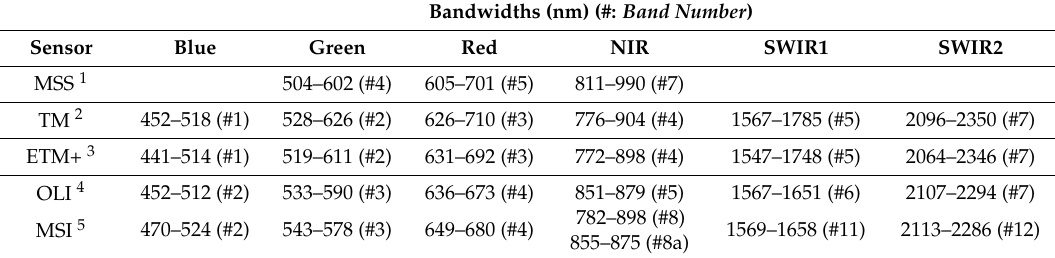
Table 2. Band correspondence between Multispectral Scanner System (MSS) (example for Landsat-1), Thematic Mapper (TM) (example for Landsat-5), Enhanced Thematic Mapper Plus (ETM+), Landsat-8 (OLI) and Sentinel-2A (MSI) (example for Sentinel-2A), fitting the continuity of the Landsat Program. Bandwidths (nm) (#: Band Number